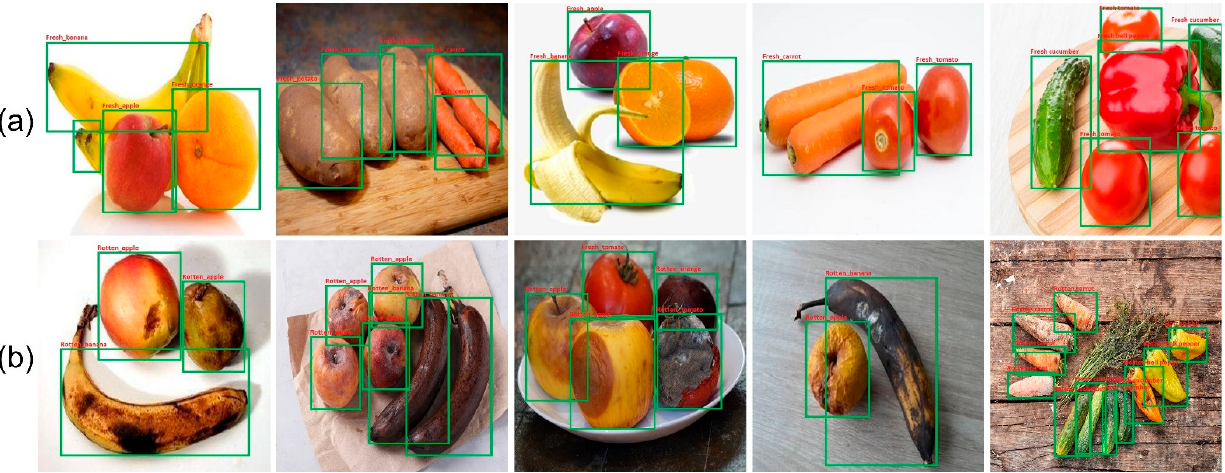
Figure 6. Classification results of the proposed fruit and vegetable model for multiple objects in single image: ( a ) fresh fruits and vegetables, ( b ) rotten fruits and vegetables.